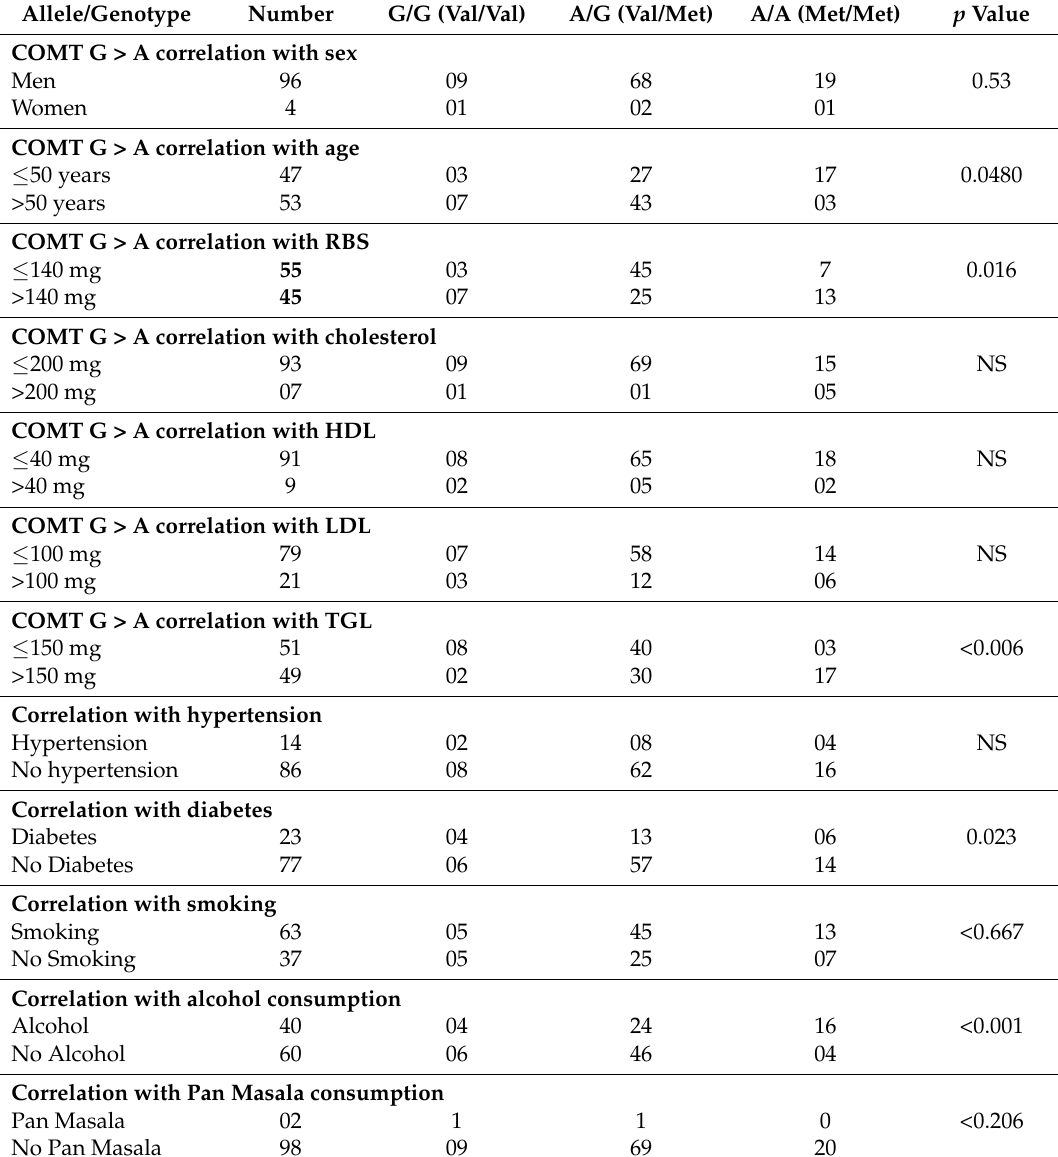
Table 5. Clinical correlation of COMT polymorphism with respect to clinicopathological characteristics of CAD patients and